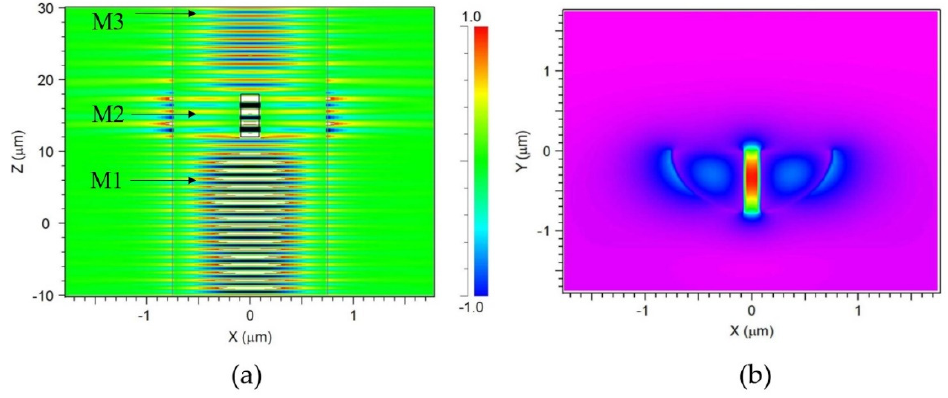
Figure 5. ( a ) The electric field distribution of incident light propagating through the SW in DSCF whose silicon core diameter was 1.5 µm. ( b ) The electric field of the cross section of the slot region .